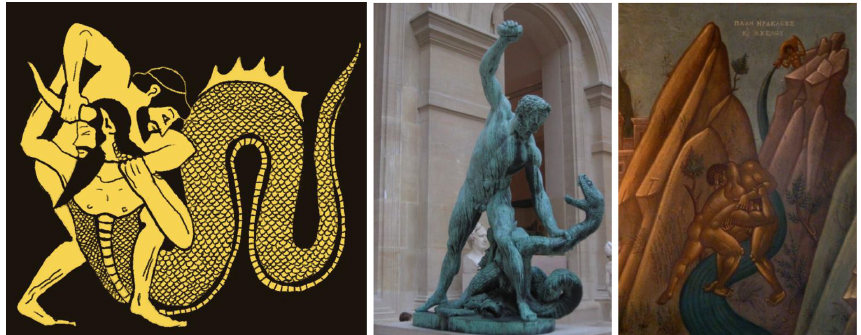
Figure 1. Different depictions of the mythological battle of Hercules against Achelous; (left) on an Attic red-figure vase, 6th century BC, kept in the British Museum (reproduced from Koutsoyiannis et al., 2007); (middle) in a modern sculpture, Hercule combattant Achéloüs métamorphosé en serpent by François Joseph Bosio in 1824 exhibited at the Louvre (source: https://commons.wikimedia.org/wiki/File: 1937–1939 with Byzantine aesthetics (reproduced from Koutsoyiannis et al., 2012).